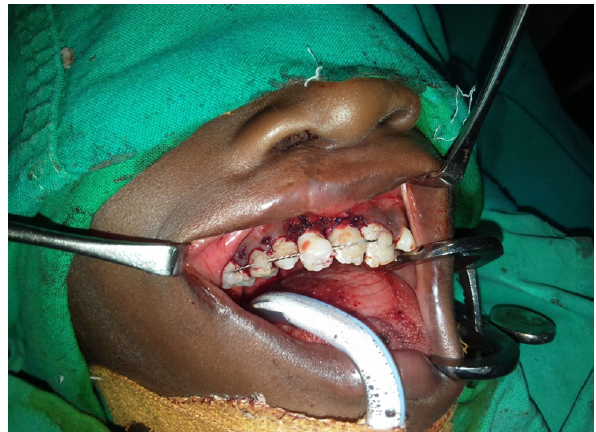
Figure 2: Intra-operative photograph; after transplantation of lateral incisor splinted with wire and composite.